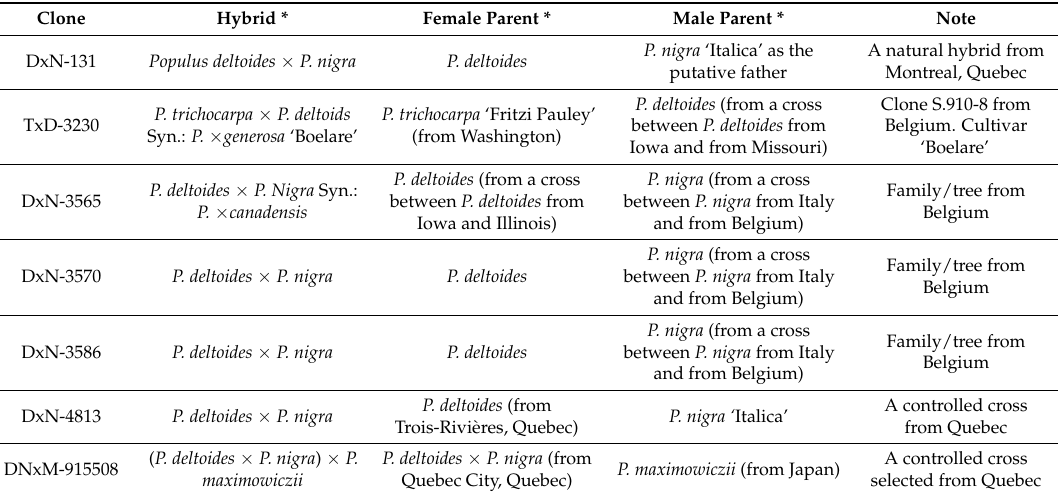
Figure 1. Map of sampling sites located in the south of the Province of Quebec, Canada. Table 2. Clones of hybrid poplar selected for the study [1,2,21].